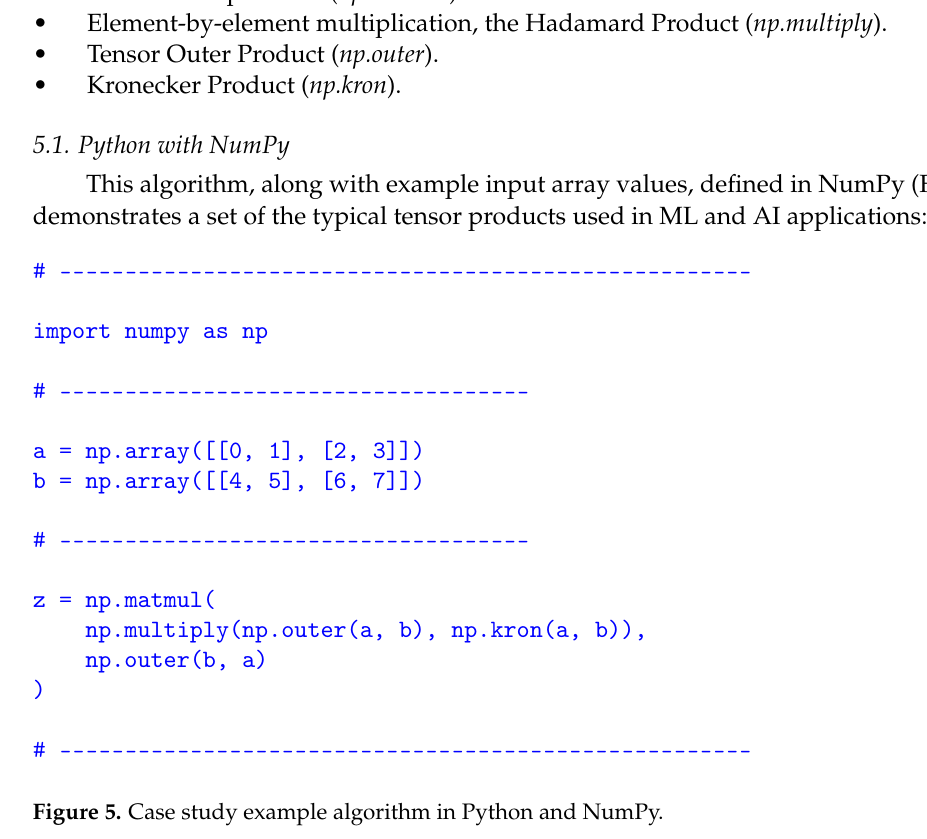
Figure 5. Case study example algorithm in Python and